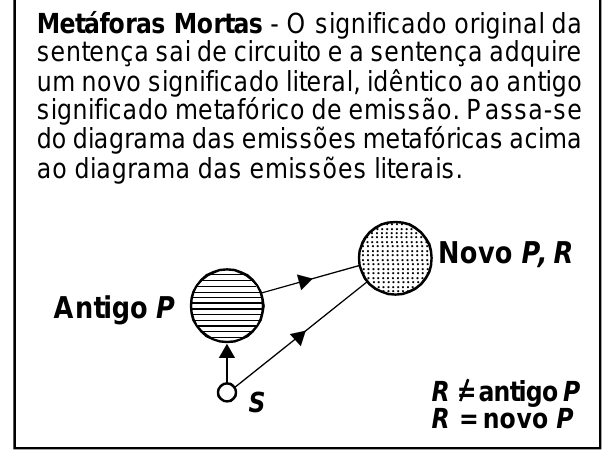
Figura 1 . Esquema apontado por Searle (1995) para a compreensão das metáforas Nesta figura, o autor propõe que o sentido, originaria- mente metafórico, se torna, pela repetição e pelo uso, o atu- al sentido literal da palavra ou da expressão. Isto é, o sujei- to S chegava ao significado R passando pelo significado P.